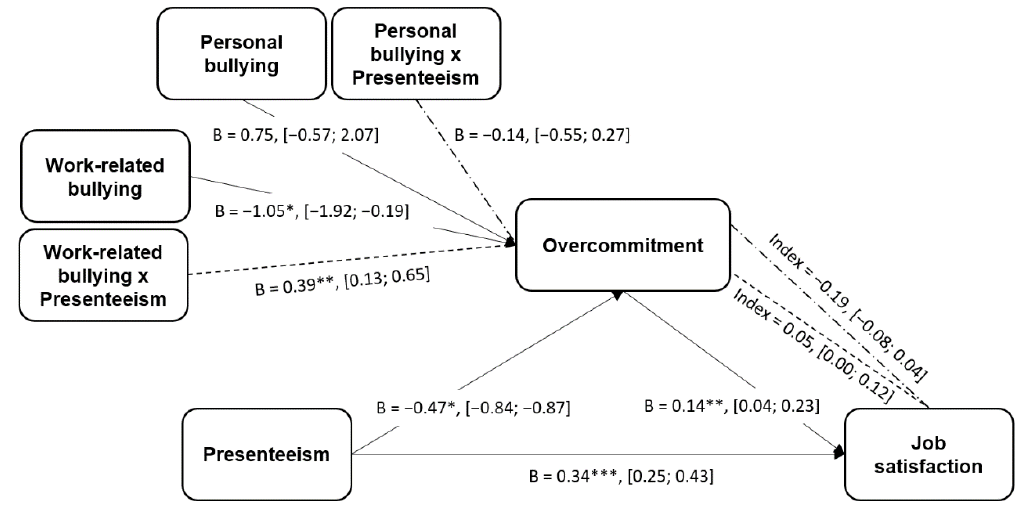
Figure 2. The statistical model where coefficients and effect sizes may be observed. ( Note : * p < 0.05, ** p < 0.01, *** p < 0.001).